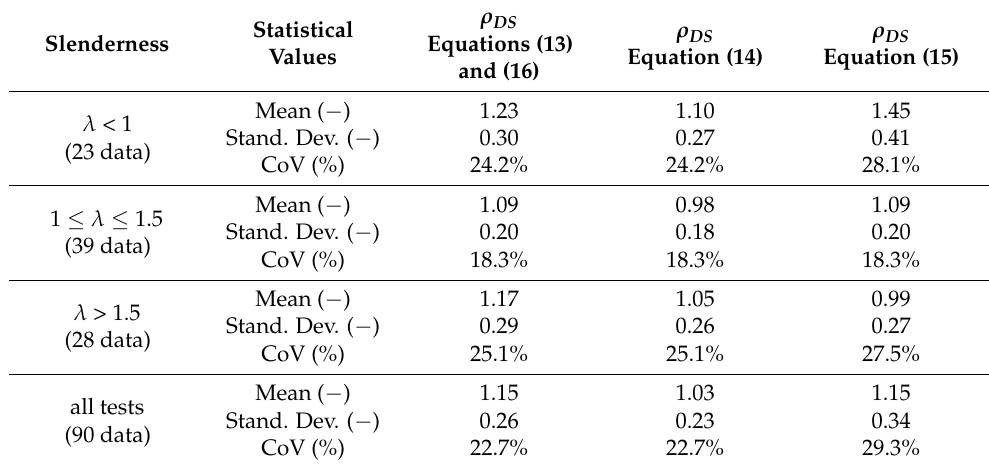
Table 11. Mean, standard deviation and CoV associated with the ratio ρ DS